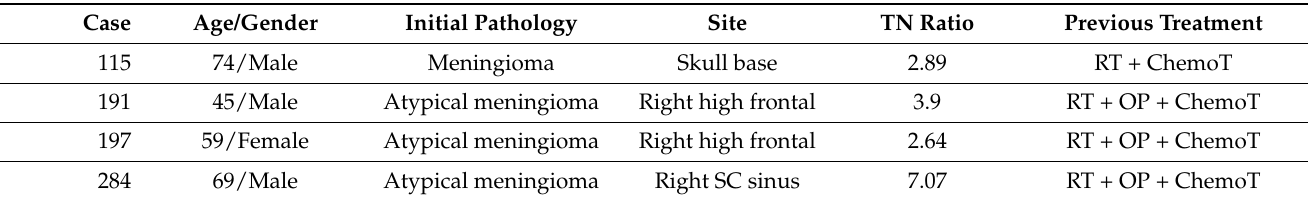
Table 3. Patient characteristics, including the pathology and the tumor site. TN ratio: tumor-to-normal tissue ratio; RT: radiotherapy; ChemoT: chemotherapy; OP: operation; SC sinus: spheno-cavernous